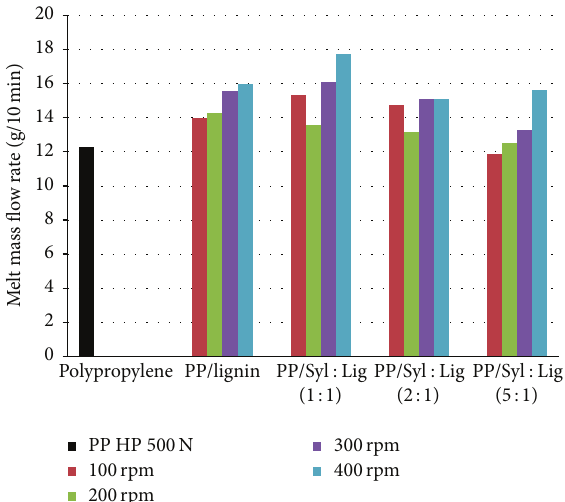
Figure 8: Mass melt flow rate for all tested materials versus applied screw speed.